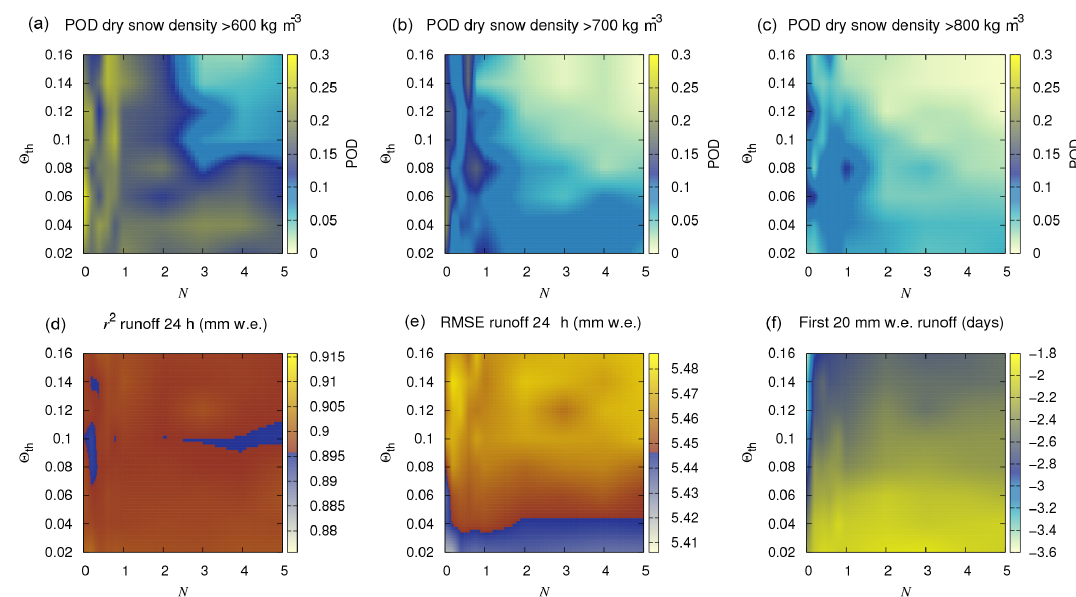
Figure 4. Interpolated results of the sensitivity study for the parameters N and (cid:50) th for the probability of detection (POD) when modelled dry snow density exceeds 600kgm − 3 (a) , 700kgm − 3 (b) , or 800kgm − 3 (c) within 20cm of the observed ice layer. For runoff, the r 2 for daily sums of runoff (d) , the RMSE error for daily sums of runoff (e) and the number of days difference between modelled and measured passage of 20mmw.e. since 1 March of each snow season (f) are shown. The jump in colour scale from blue to red in (d) and (e) marks the score achieved with matrix flow